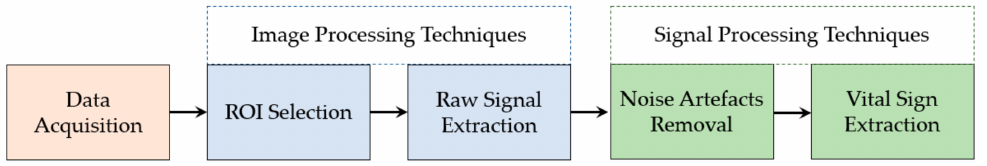
Figure 2. Block diagram of contactless monitoring system.